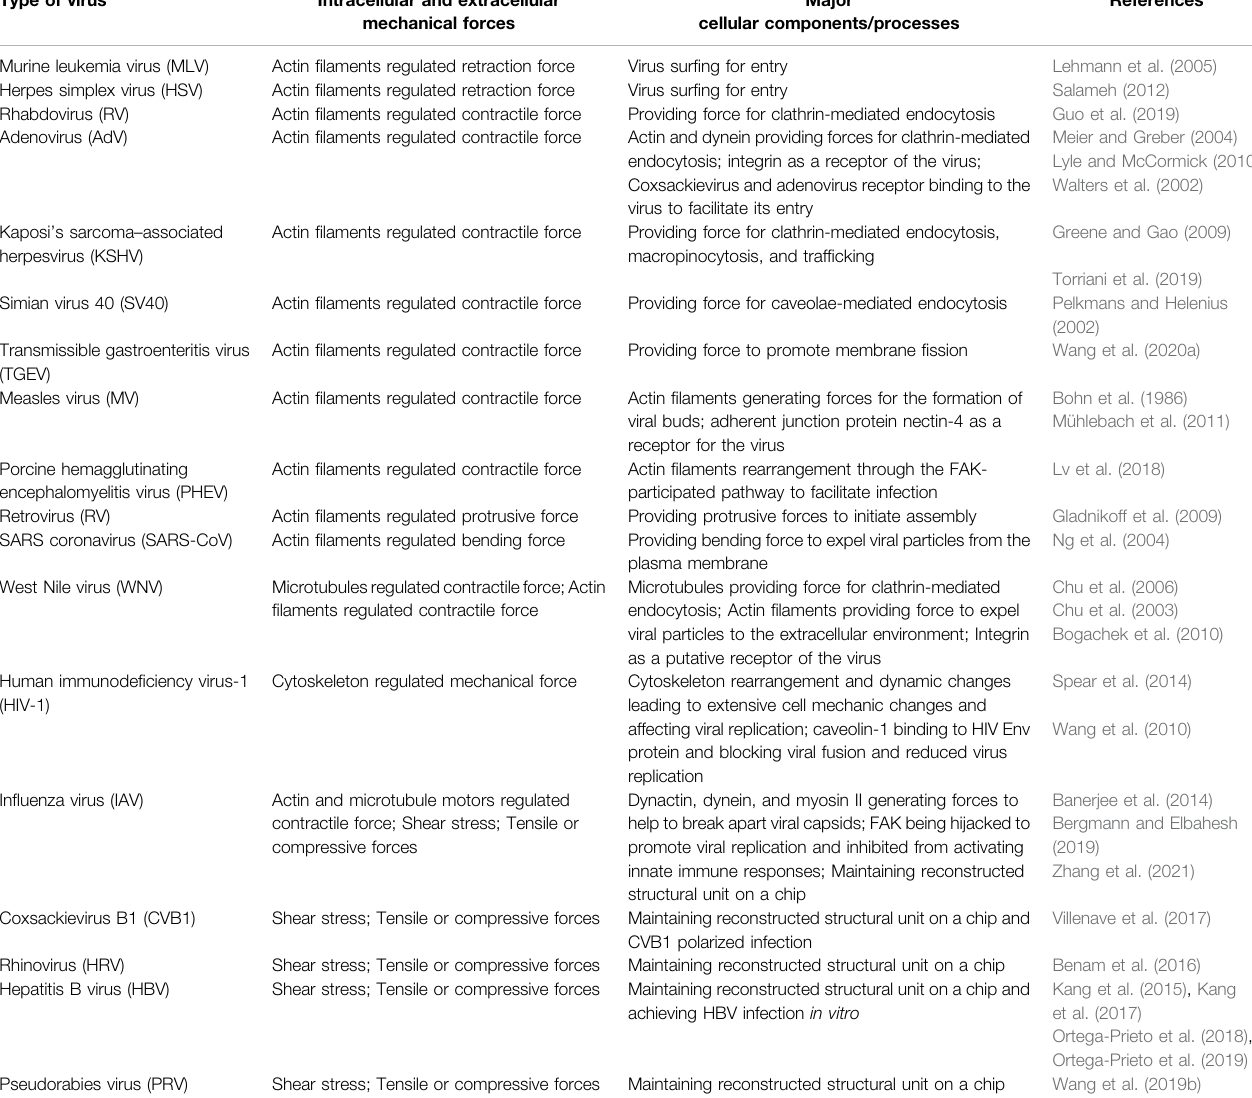
TABLE 1 | Mechanical forces regulate viral infection and